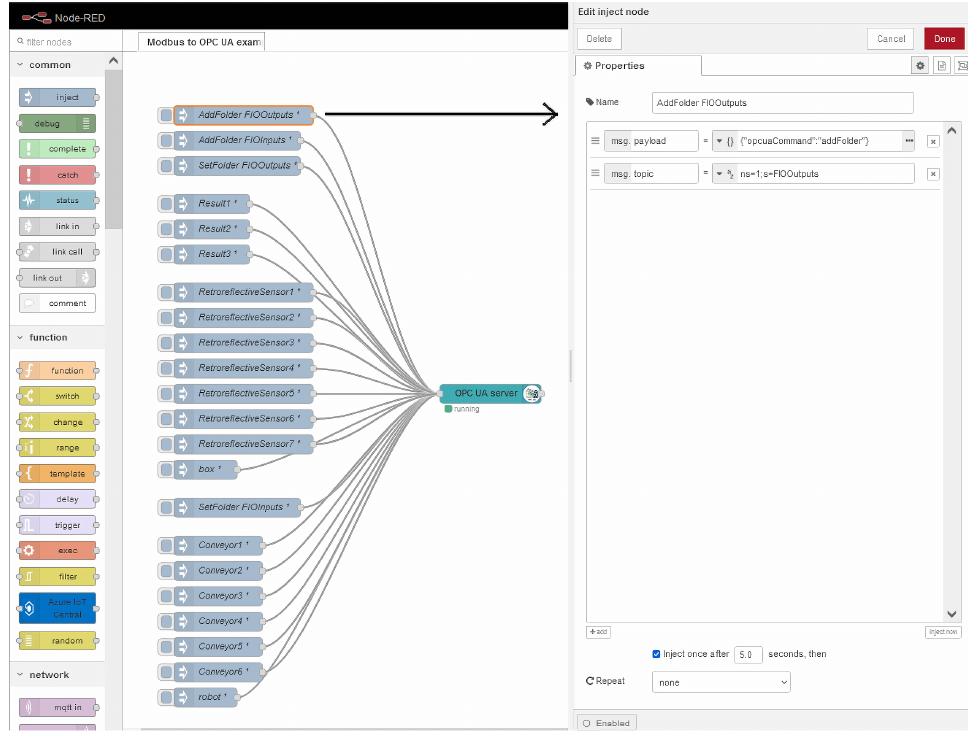
Figure 12. Creating OPC UA server and its address space in